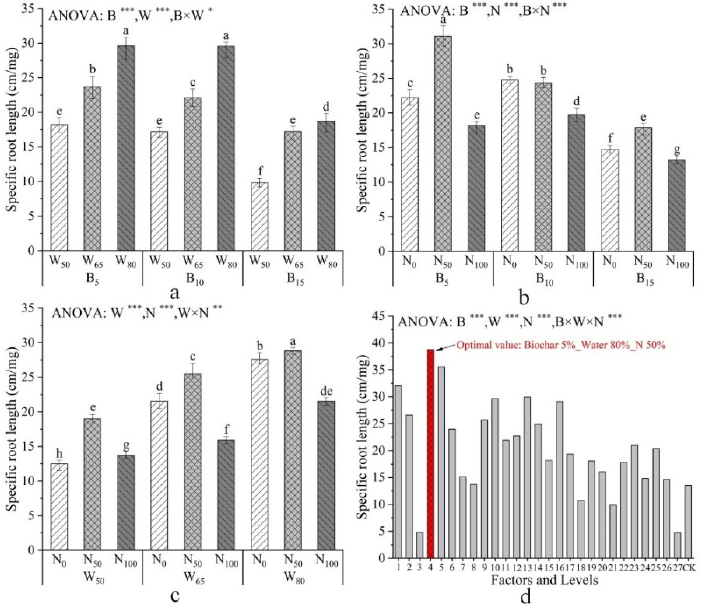
Figure 2. Effects of the specific root length with different treatments of seedlings: ( a ) Interaction between biochar and water content; ( b ) Interaction between biochar and N; ( c ) Interaction between water content and N; and ( d ) Interaction between biochar, water content, and N. Note: Values with different lower case letters were used in the same column to indicate the significance of the difference when p < 0.05; *** ( p < 0.001), ** ( p < 0.01), * (0.01 < p < 0.05) were used to indicate whether there was remarkable difference between different treatments.